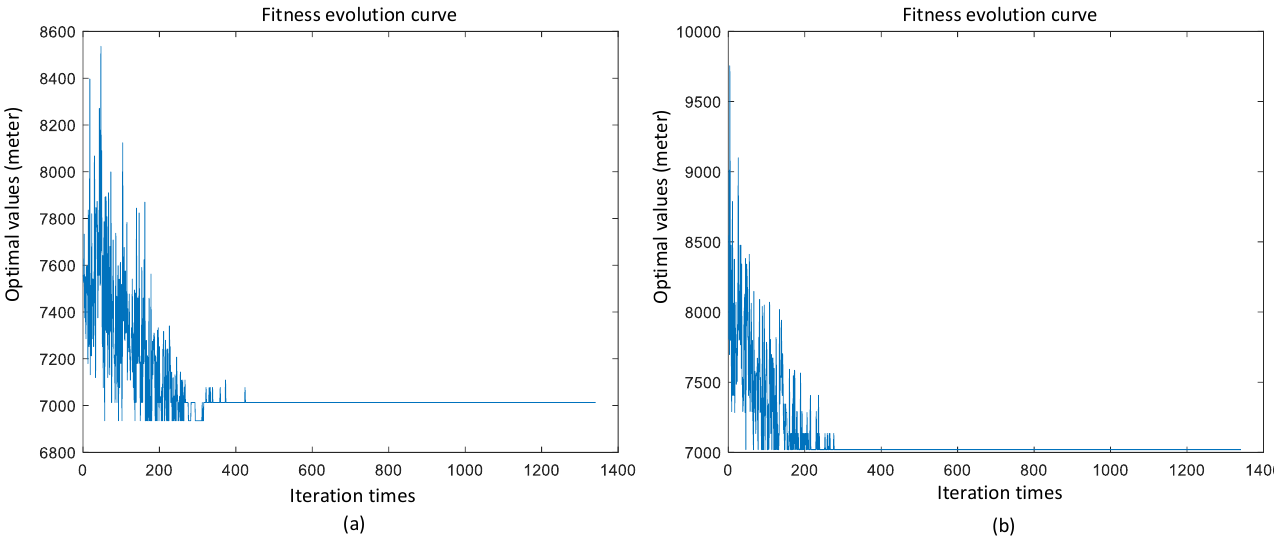
Figure 8. The maintenance optimization when 7 turbine systems fail at the same time. ( a ) The maintenance sequence for turbines is 10, 11, 8, 5, 1, 15, and 14. ( b ) The maintenance sequence for turbines is 12, 9, 5, 8, 3, 4, and 7.